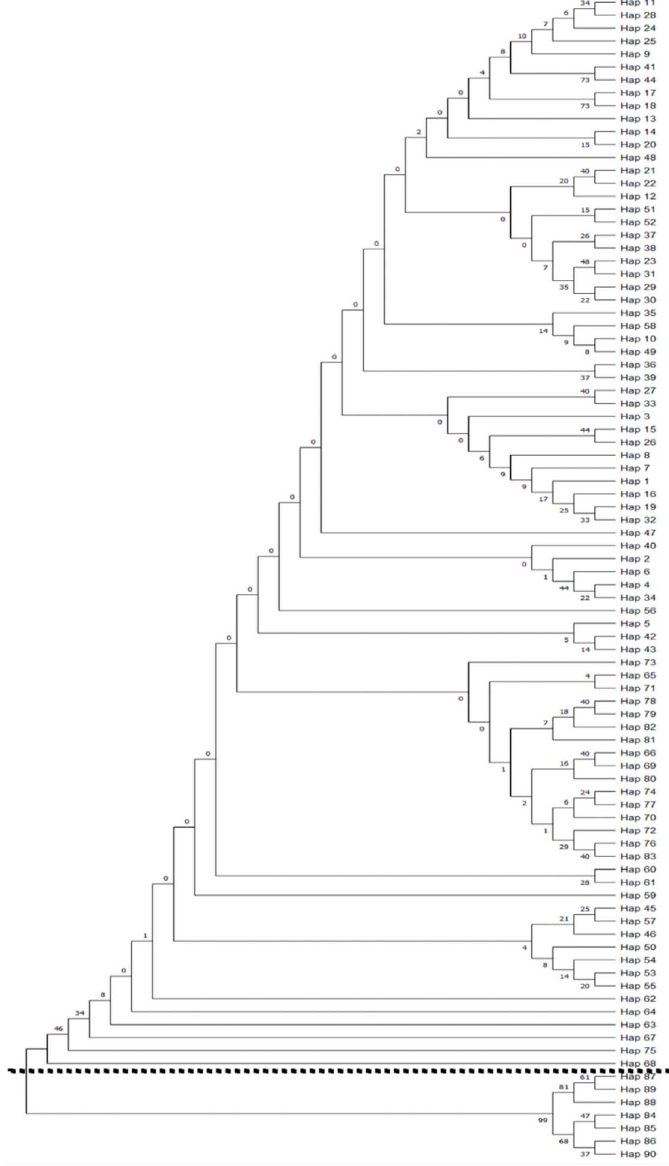
Figure 2. Neighbor-joining (NJ) tree based on control region gene sequences with bootstrap values (NJ/ML, respectively) for P. sanguinolentus . Table 2. The matrices shown below show pairwise F ST (below diagonal) and p values (above diagonal) for seven populations of P. sanguinolentus in East